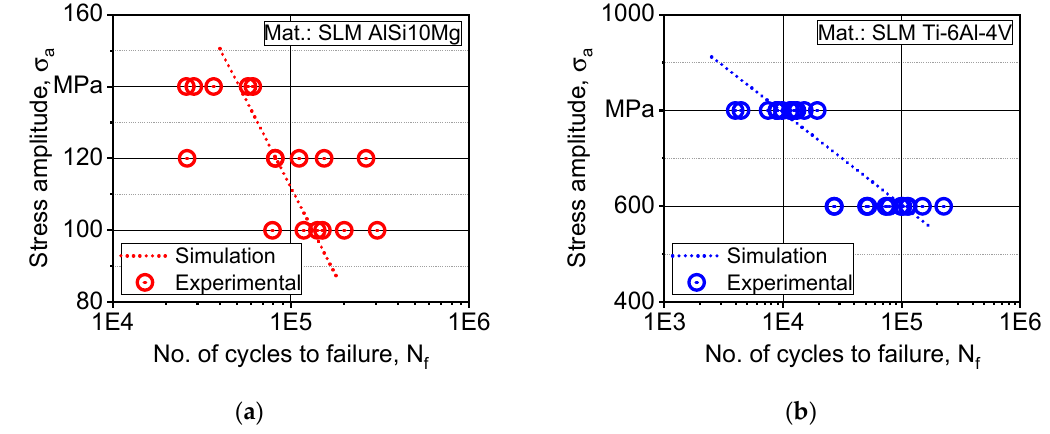
Figure 10. Evaluation of the proposed modeling scheme by comparison with experimental fatigue data: ( a ) AlSi10Mg; ( b ) Ti-6Al-4V.